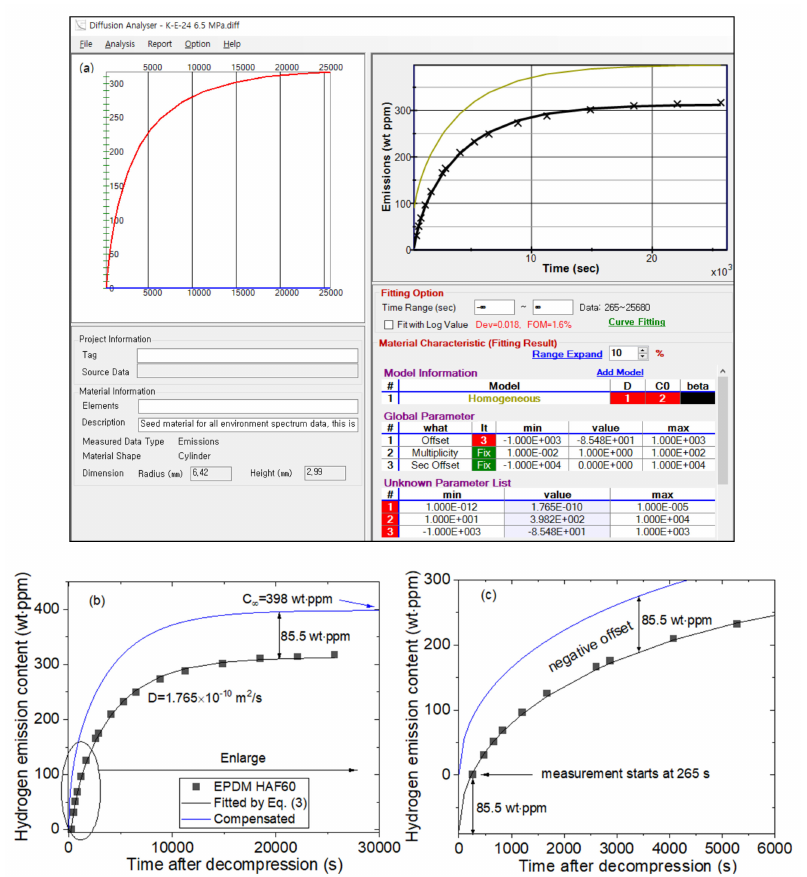
Figure 2. ( a ) Application example of the diffusion analysis program to obtain the hydrogen emission content and diffusion coefficient for EPDM HAF60 exposed to 6.5 MPa H 2 for 24 h; ( b ) redrawn diffusion analysis results; and ( c ) enlargement of the elliptical part in ( b